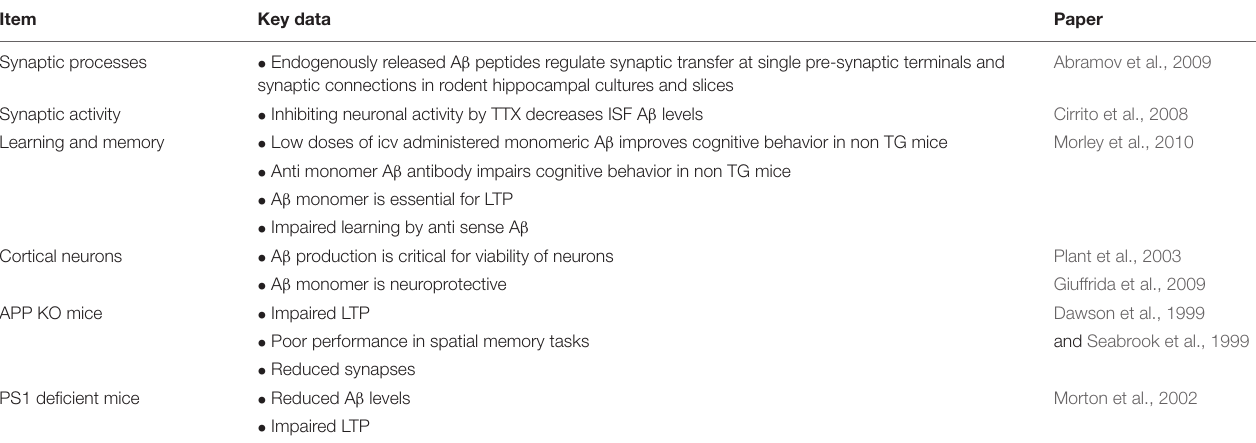
TABLE 1 | Key findings to the essential role of A β monomer in physiological synaptic processes.